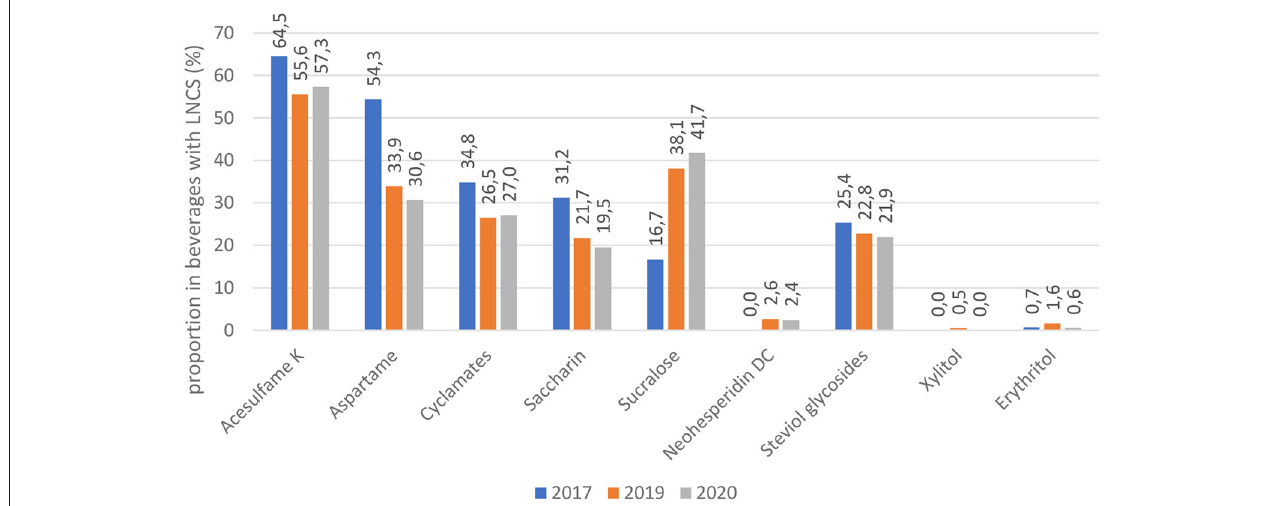
FIGURE 2 | Frequency of different low and no-calorie sweeteners (LNCS) in beverages with LNCS [data for 2017 and 2019 from Hafner et. al